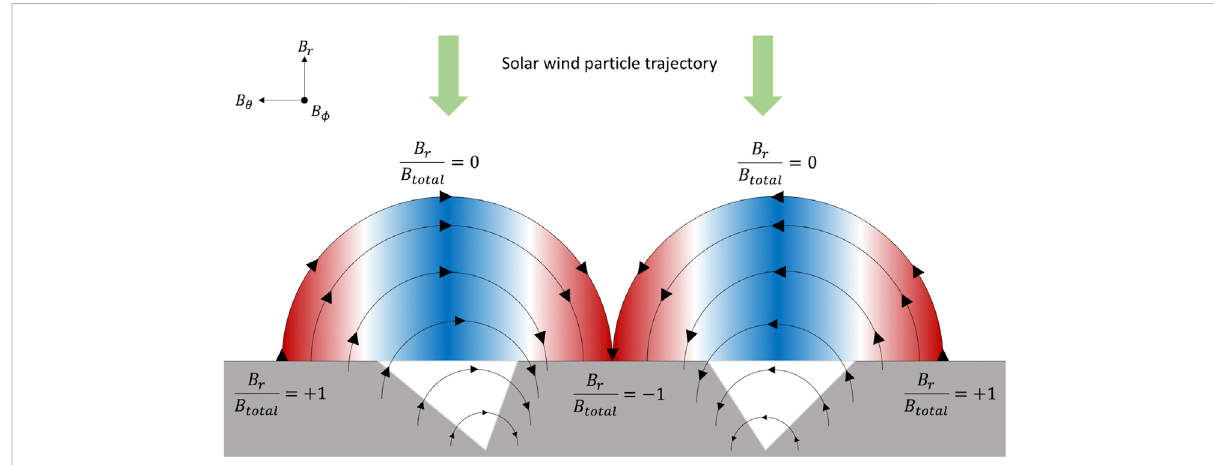
FIGURE 4 Maximum solar wind particle de fl ection via the Lorentz force would occur at a mini-magnetosphere where the incident solar wind trajectory is perpendiculartothemagnetic fi eldlines;for anequatorial MA,maximumparticle de fl ectionoccurswhere B r /B total isnearzerobetweentworegions of B r /B total near ± 1. This diagram represents the reduced weathering effect of particle de fl ection observed in albedo, where the bright areas suffer less weathering than the surrounding regolith due to de fl ection by the above-surface magnetic structure. As in Figure 3, the bright portions of the swirl correspond to the highlighted blue region in the fi gure and the dark lanes correspond to the highlighted red